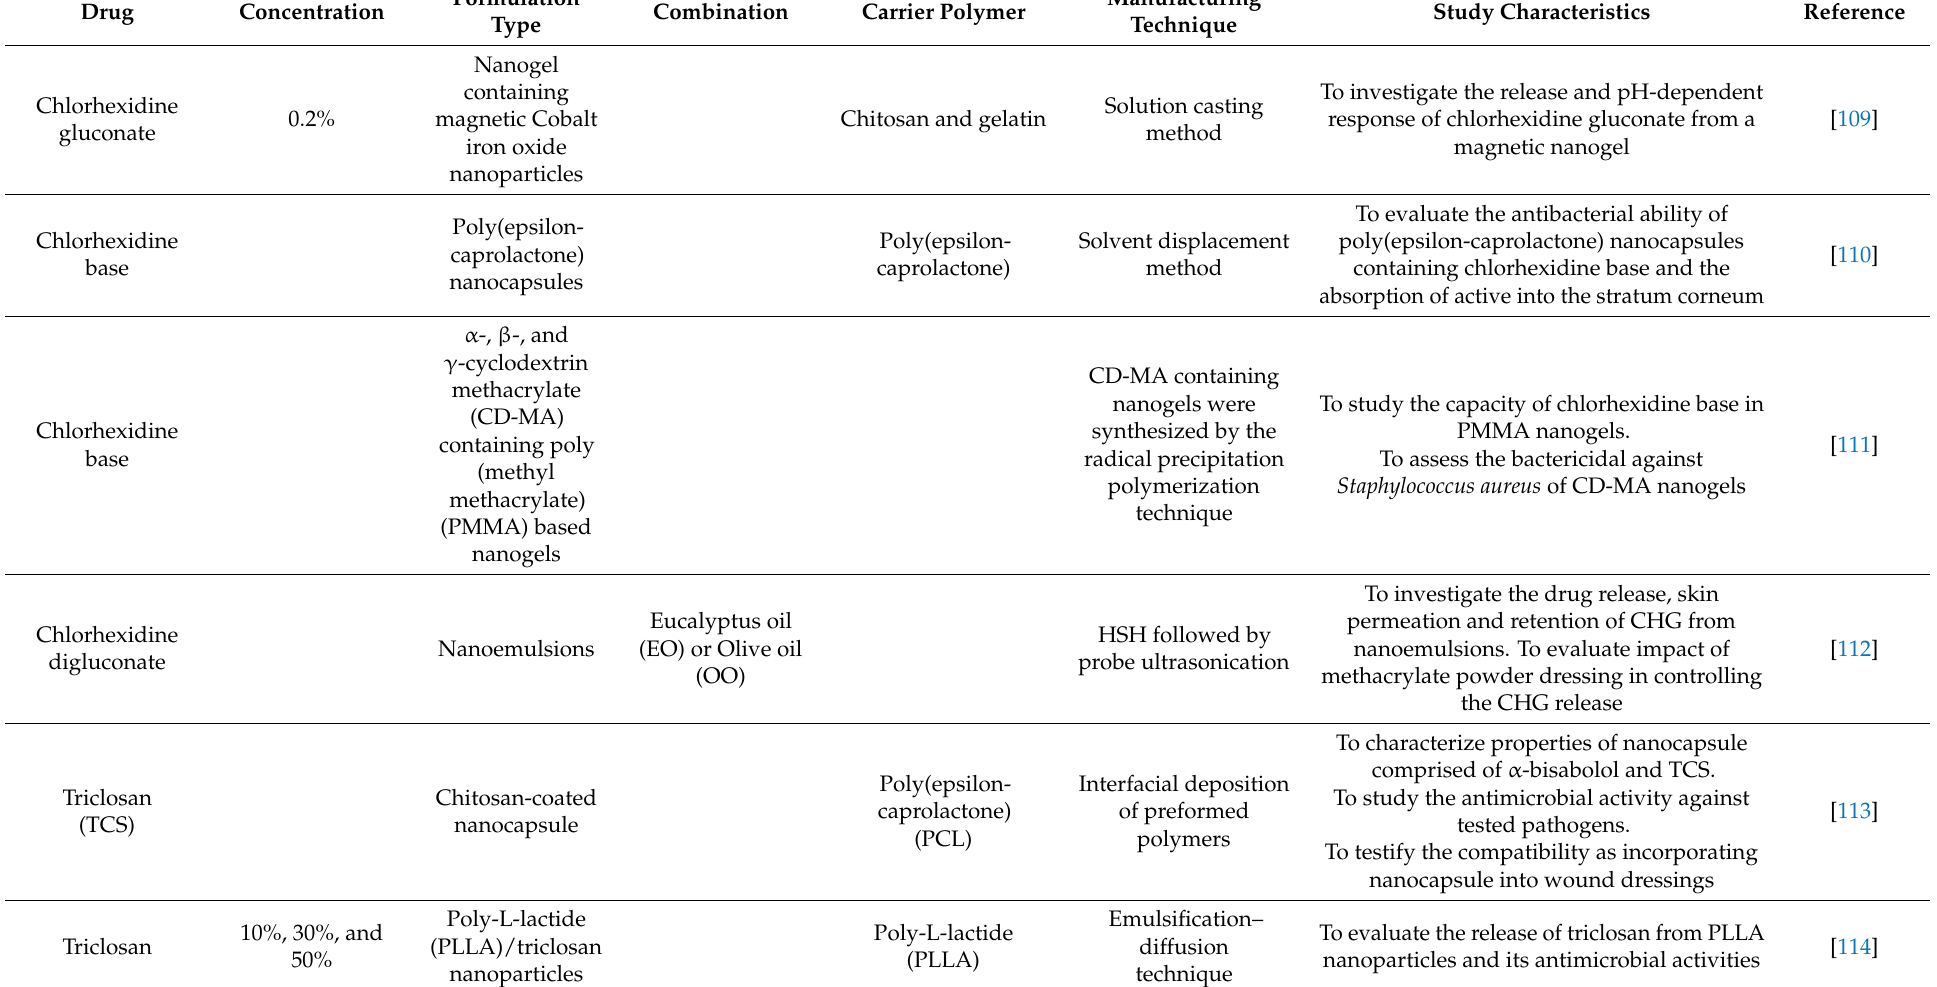
Table 2. Summarised characteristics of advanced skin antiseptic